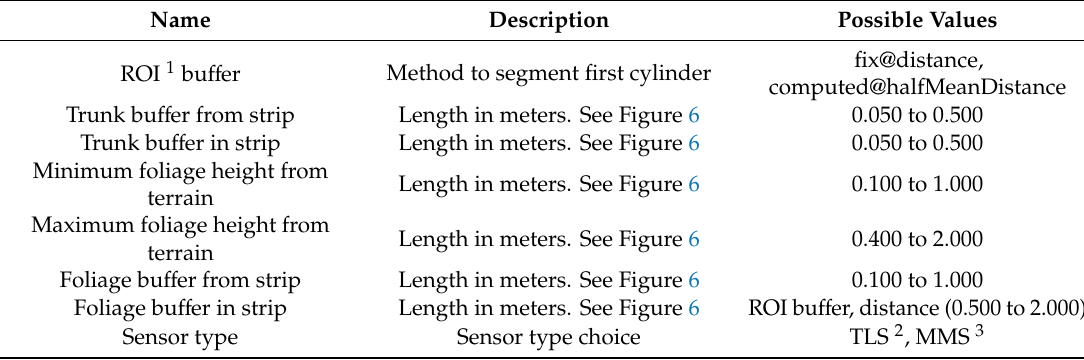
Table 2. List of the editable parameters of the cylinder and square clipping